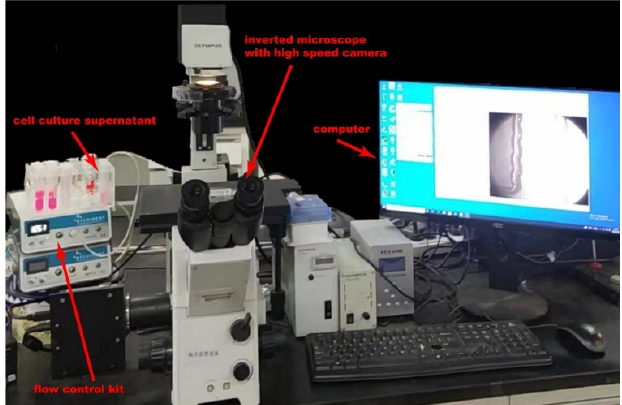
Figure 2. The experiment setup.